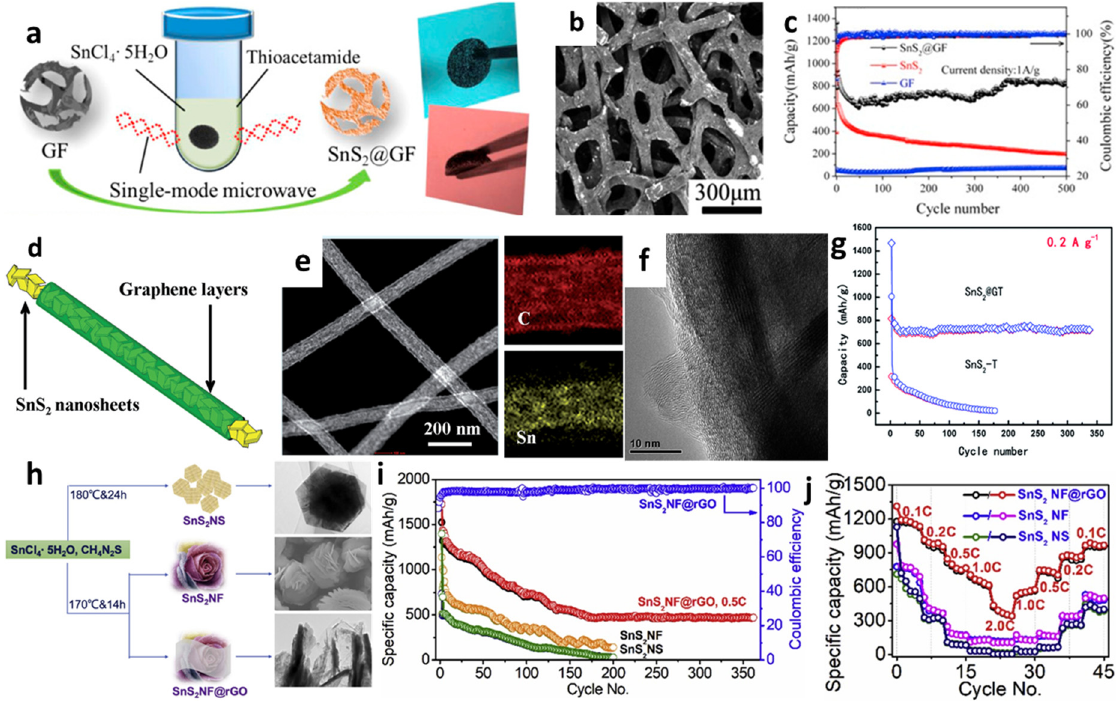
Figure 10. ( a ) Schematic illustration of the formation, ( b ) an SEM image, and ( c ) cycling